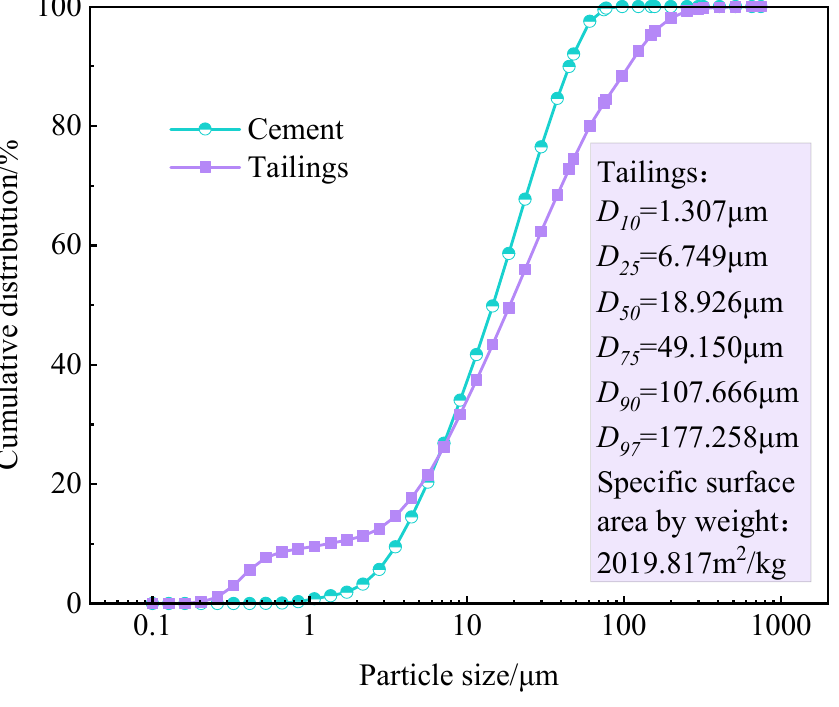
Figure 1. GSD curves for cement and gold tailings.